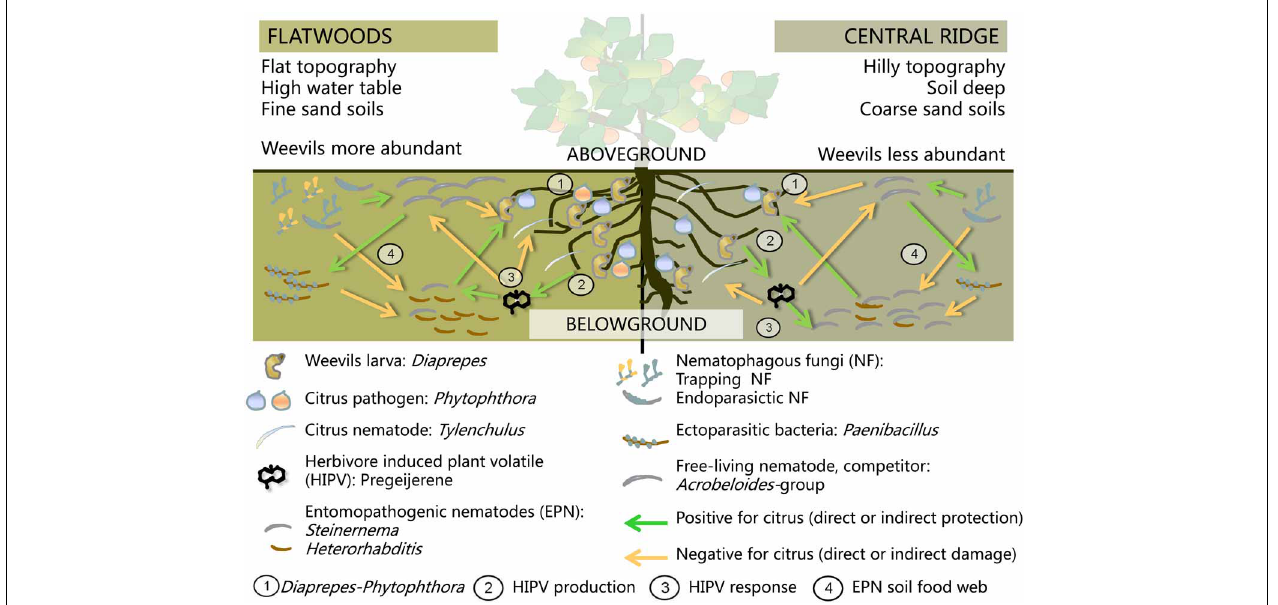
FIGURE 3 | Scheme of the belowground interactions among organisms on the citrus groves from Florida and their possible positive (green arrows) or negative (orange arrows) impact on the citrus production and health. Selected trophic groups are represented: herbivore, citrus pathogens, plant-parasitic, entomopathogenic and free-living nematodes, nematophafous fungi, and ectoparasitic bacteria. Differences in number of individual and species composition are represented for two eco-region, central ridge, and fatwoods (see correspondence with colors and numbers in each part of the